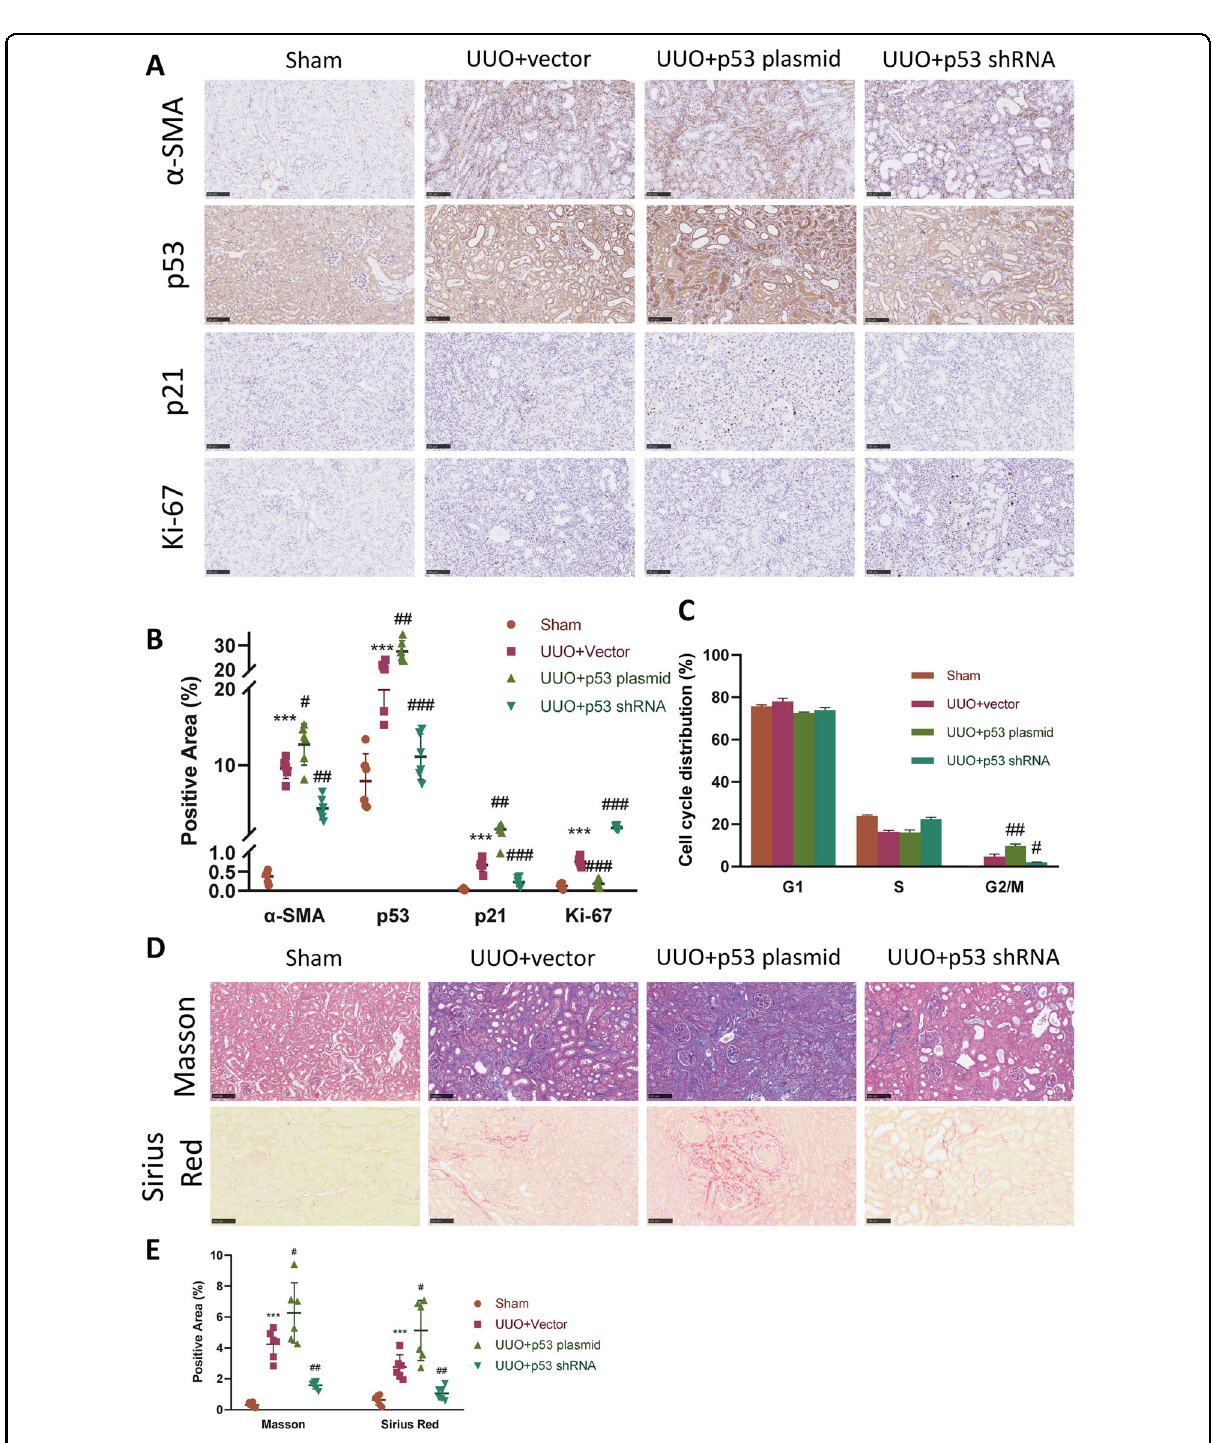
Fig. 6 Regulation of p53 expression changes G2/M arrest and EMT. To regulate the expression of the p53 – p21 axis, UUO mice were injected with plasmid encoding either p53 mRNA or p53 shRNA 1 day after UUO establishment. A Immunohistochemistry staining of α -SMA, p53, p21, and Ki- 67 in kidneys of sham, UUO + vector, UUO + p53 plasmid, and UUO + p53 shRNA group and B their quanti fi cations. Scale bar = 100 μ m for α -SMA and scale bar = 50 μ m for p53, p21, and Ki-67. C Cell cycle distribution of TECs isolated from obstructed kidneys in different groups. D Masson trichrome and Sirius red staining, and E their quanti fi cations in different groups. Scale bar = 100 μ m. *** P < 0.001 compared with the sham group. # P < 0.05; ## P < 0.01; ### P < 0.001 compared with the UUO + vector